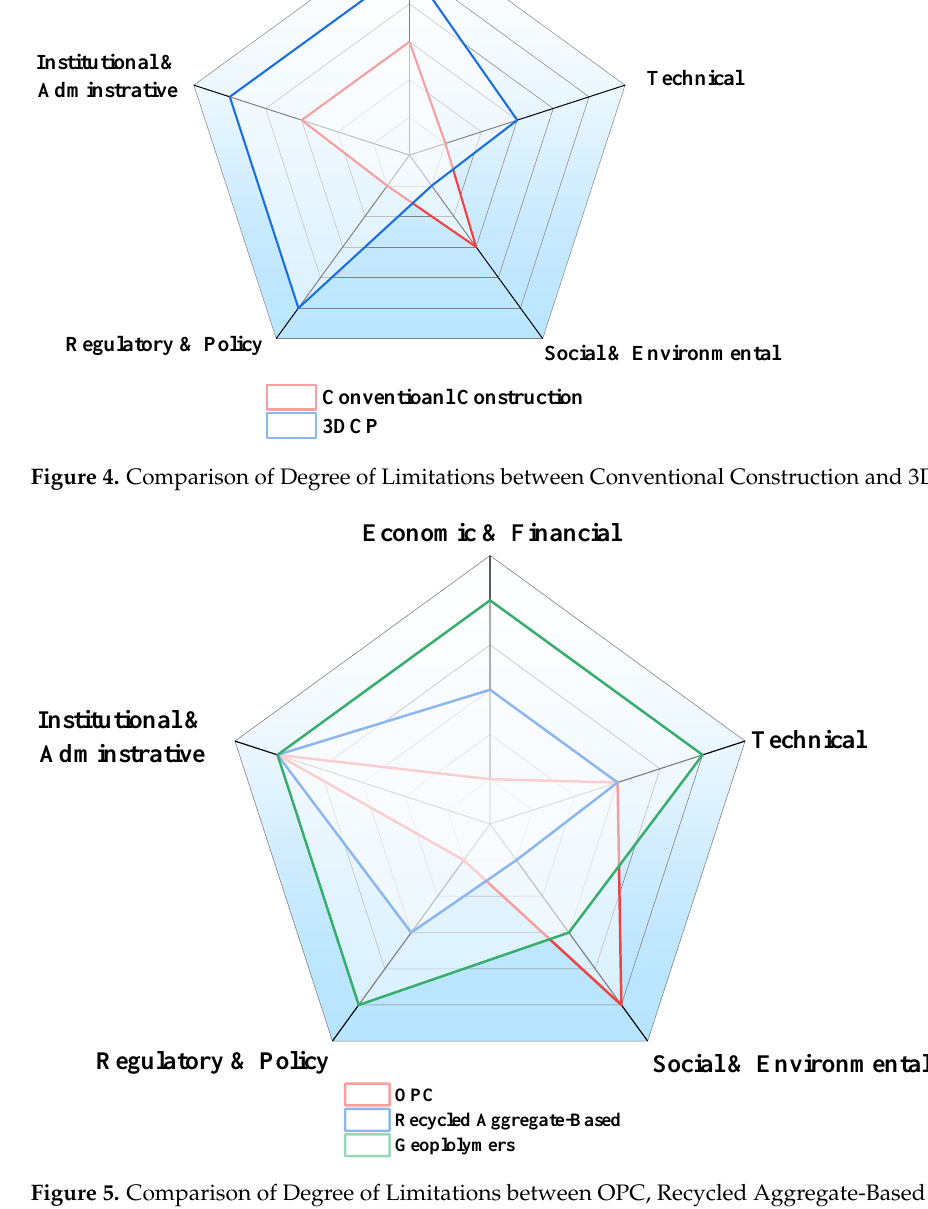
Figure 5. Comparison of Degree of Limitations between OPC, Recycled Aggregate-Based Cement, and Geopolymers for 3DCP.